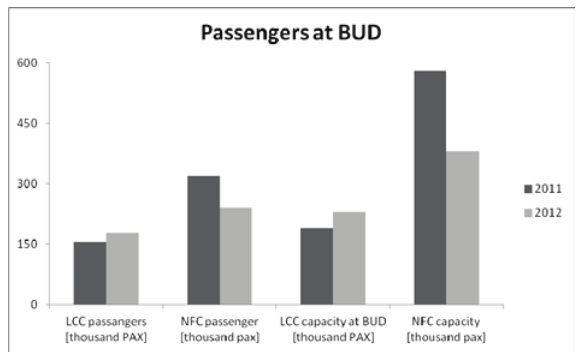
fig. 2. Passengers at Liszt Ferenc Airport (BUD) (Source: own edition based on Hungaro Control Data)